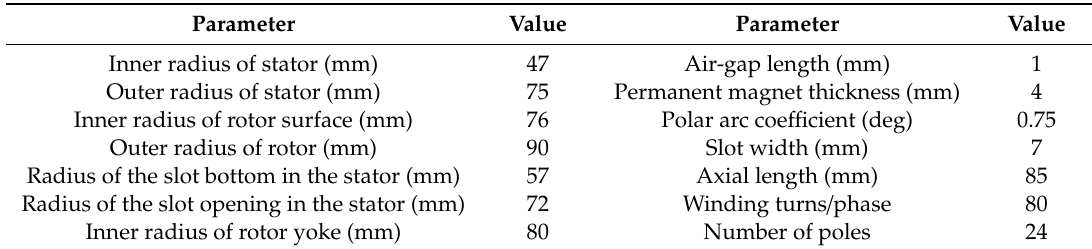
Figure 5. Magnetic field analysis at position 1: ( a ) position 1; ( b ) air-gap flux density waveforms; ( c ) harmonics of air-gap flux density.